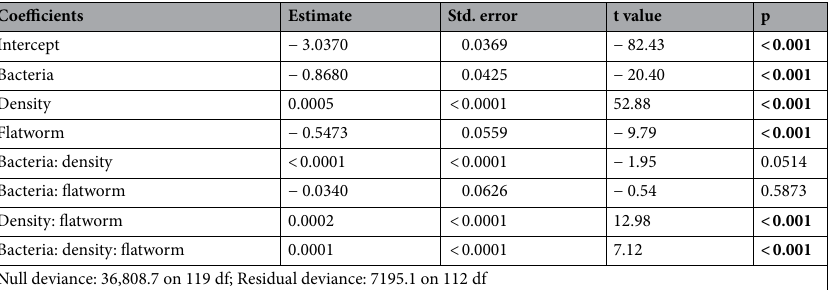
Table 1. A generalized linear model using the binomial family. Significant values are in bold. The response variable was the proportion of nematode individuals in the ECs after 12 h; the predictors were: nematode density [continuous: 500, 1000, 2500, 5000], bacterial density in the SCs [continuous: none, 10 8 cells ml −1 , 10 9 cells ml −1 ] and the absence/presence of a flatworm [2 factors]. The presented model is the one that best fit the data during model selection (details in Table S1). The estimated intercept was based on the absence of both food and predator and under a nematode density of